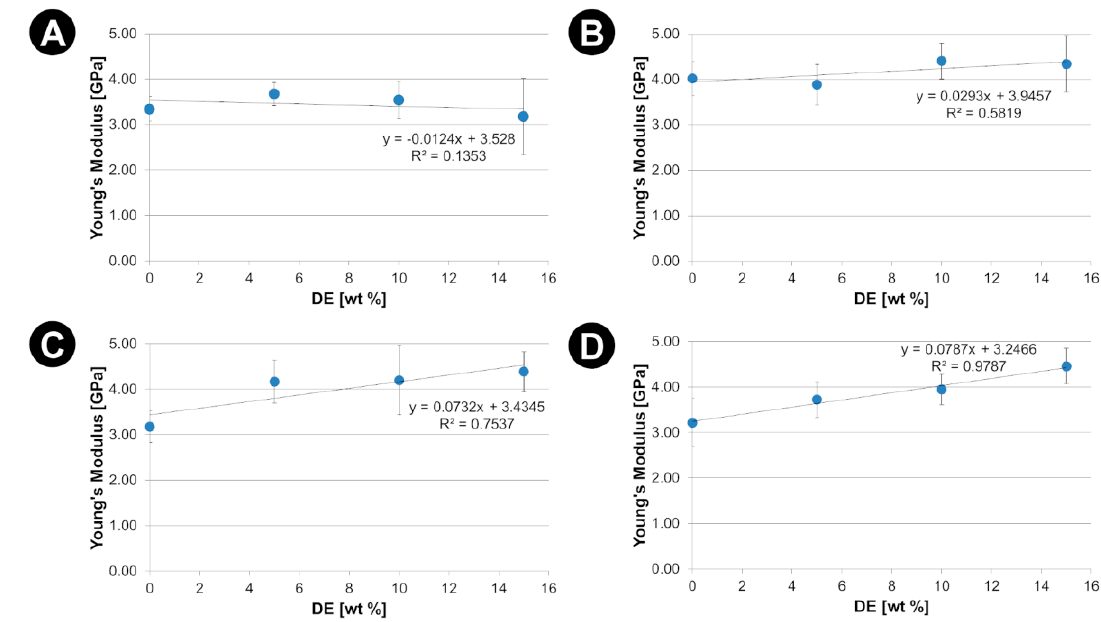
Figure 6. Young’s modulus (E) against the DE content for PLA-DE composites with ( A ) 2003D; ( B ) 3001D; ( C ) 3251D and ( D ) 4043D PLA as a matrix.